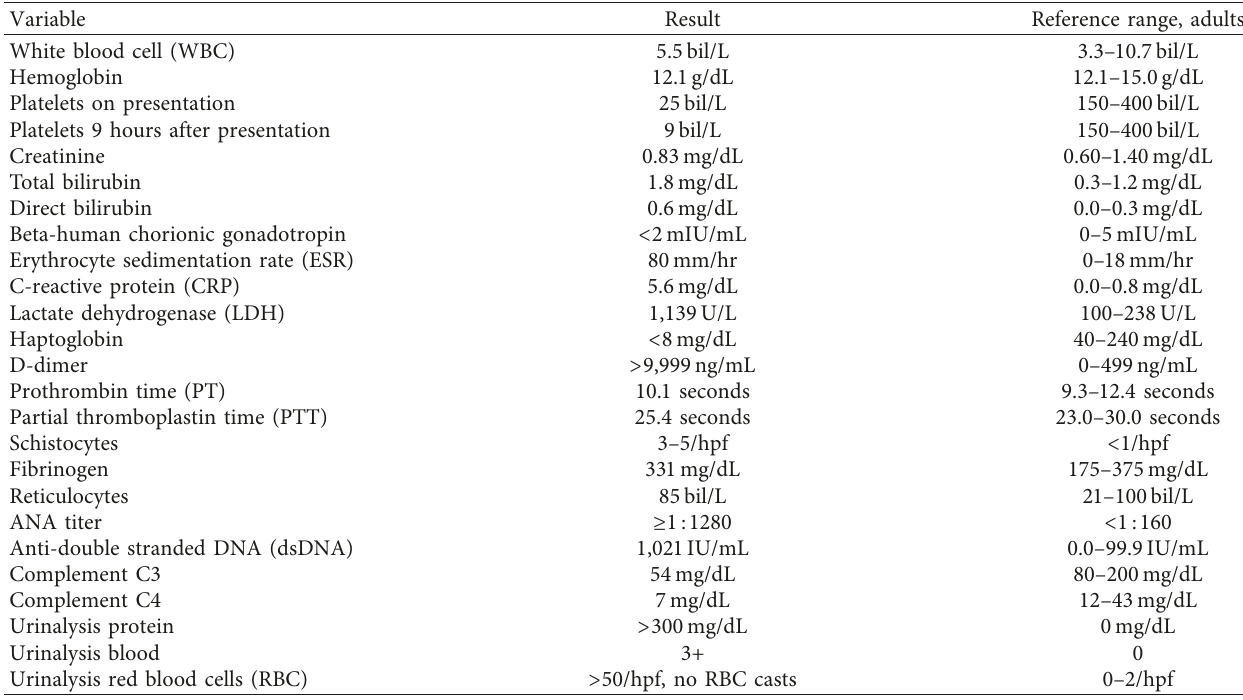
Table 1: Laboratory test results within 24